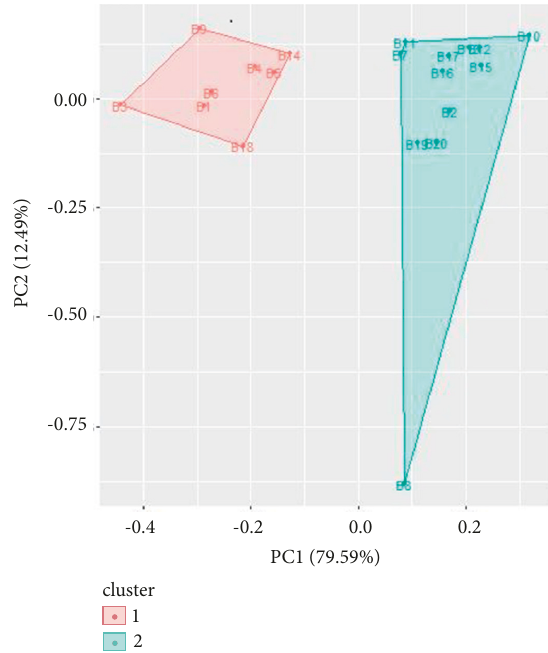
Figure 9: Cluster analysis for UV/Vis spectroscopy data for blue ballpoint pen inks.